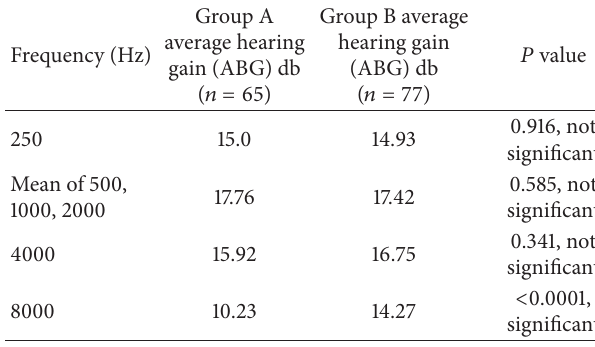
Table 3: Comparison of success rates of different graft materials in